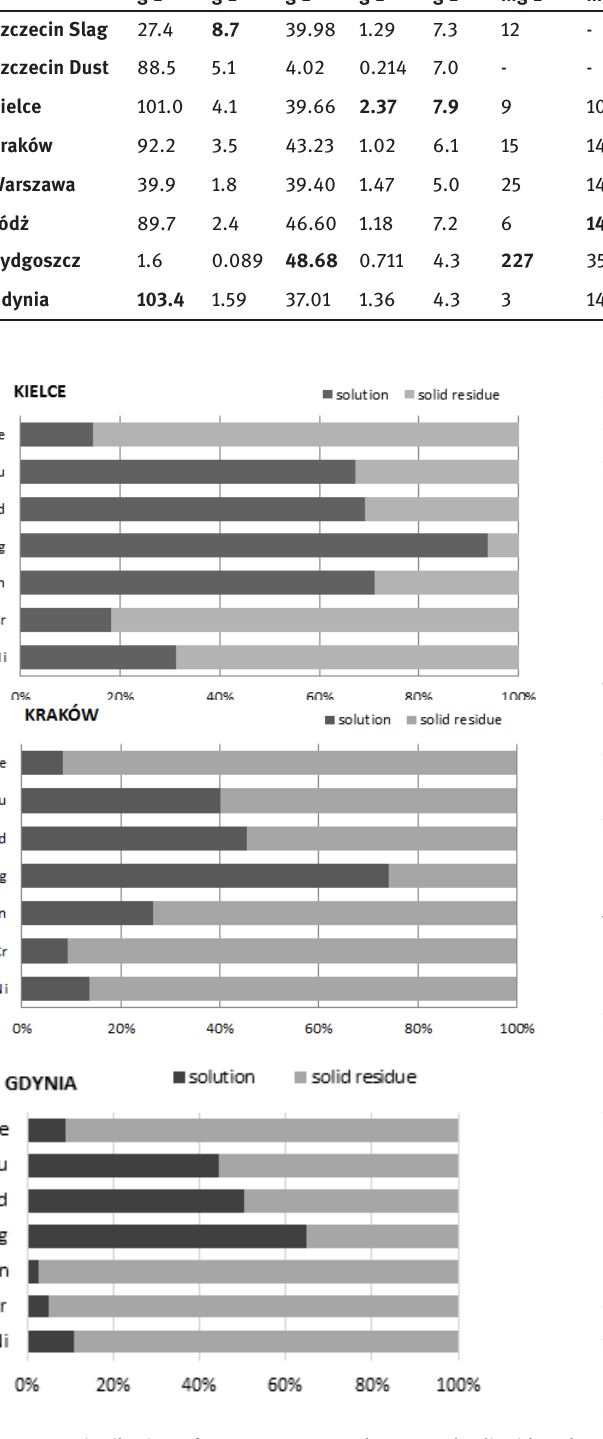
Figure 4: Distribution of SSA components between the liquid and solid phase for Kielce, Kraków and Gdynia